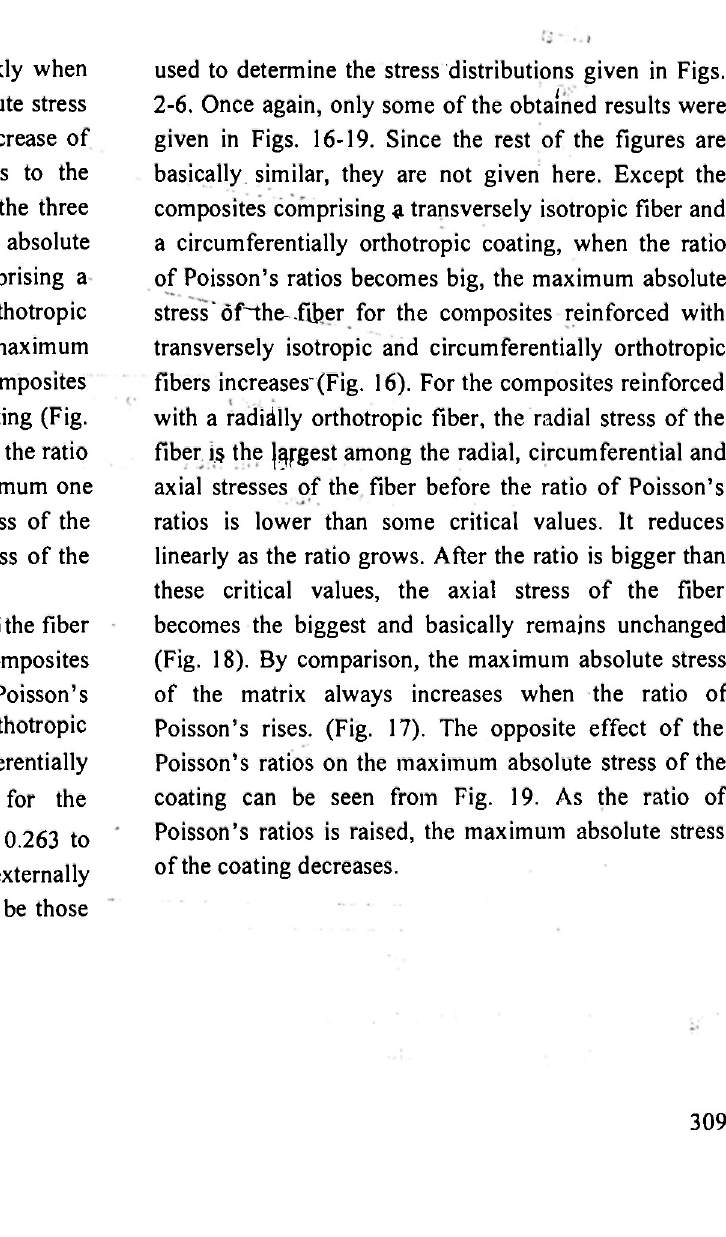
Fig. 15: Effect of Young's moduli of fiber on maximum absolute stress of fiber for composites reinforced with a radially orthotropic